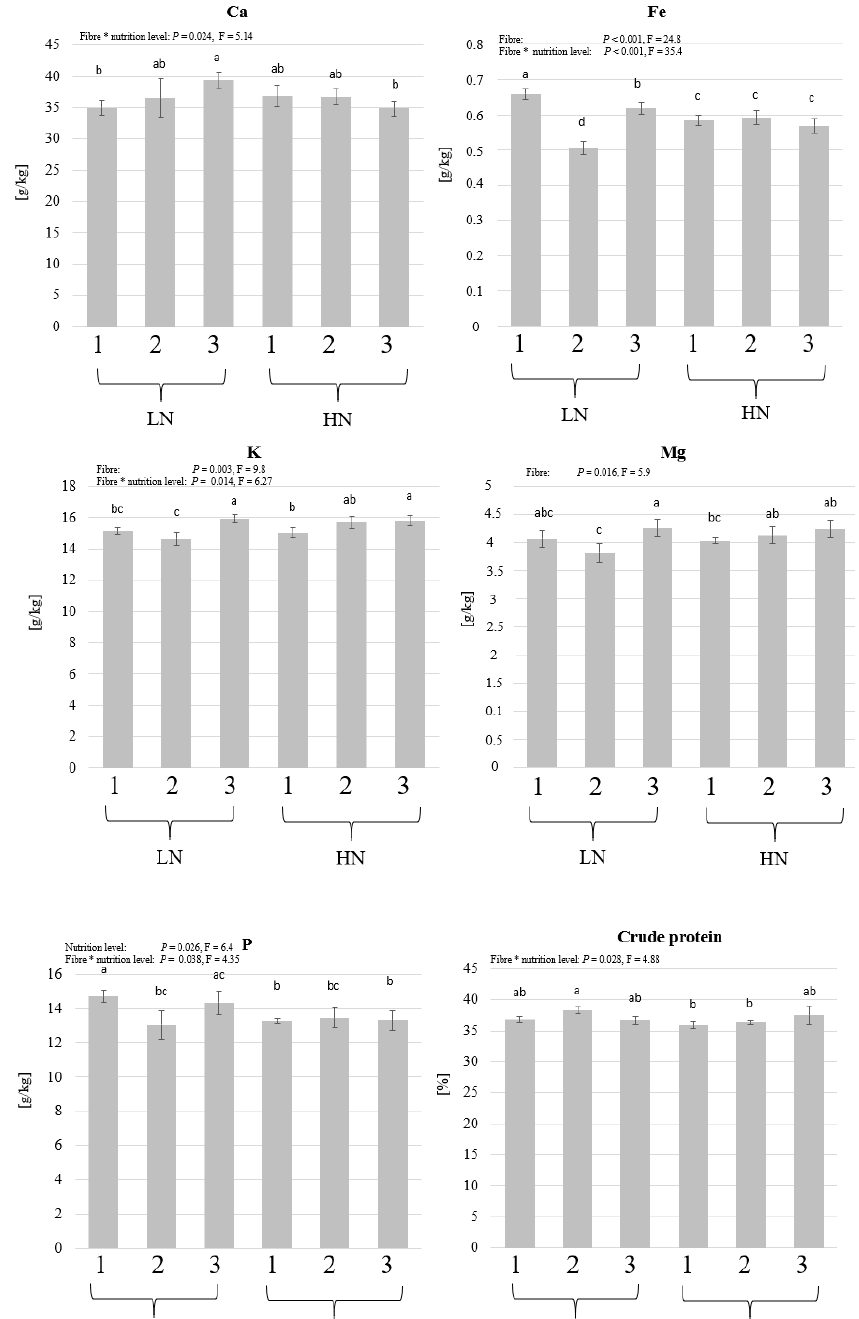
Figure 4. Protein and micronutrients in black soldier fly (BSF) larvae grown on different fibre components and two nutrient levels. BSFL were grown in high-nutrient (HN) or low-nutrient (LN) substrates and with 3 fibre components (1: powder cellulose, 2: lignocellulose, or 3: ground straw). Shown are the means and standard deviations of crude protein, Ca, Fe, K, Mg, and P in the harvested larvae. Two-way ANOVA (n = 5, p < 0.05) followed by a Bonferroni post hoc test revealed a significant impact of the factor “fibre” on Fe, K, and Mg, and an influence of the “nutrient level” only on the P level. An interaction was observed in Ca, Fe, P, K, and crude protein concentrations. The letters above the columns indicate the different groups and the asterisk (*) between factors indicates the